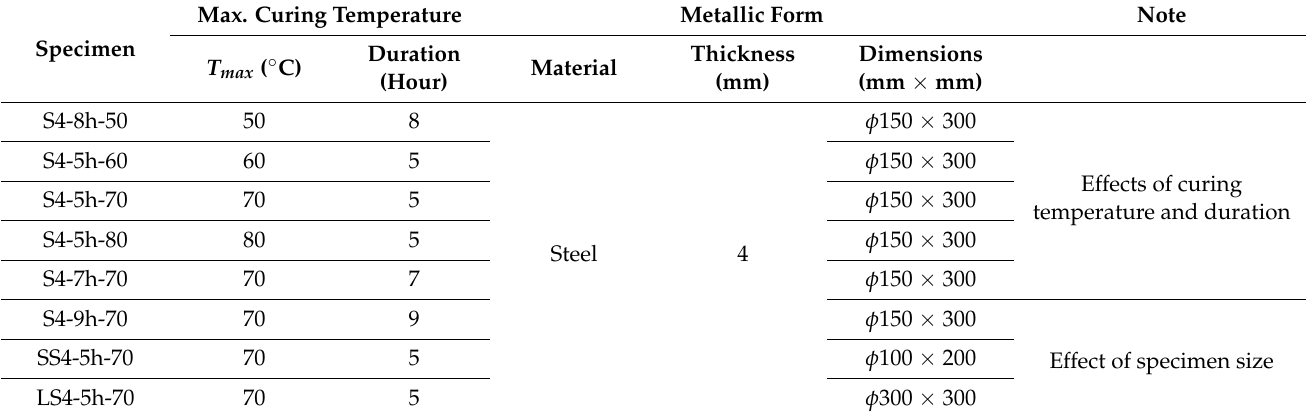
Table 1. Test variables for evaluating the properties of concrete cured by induction heating.